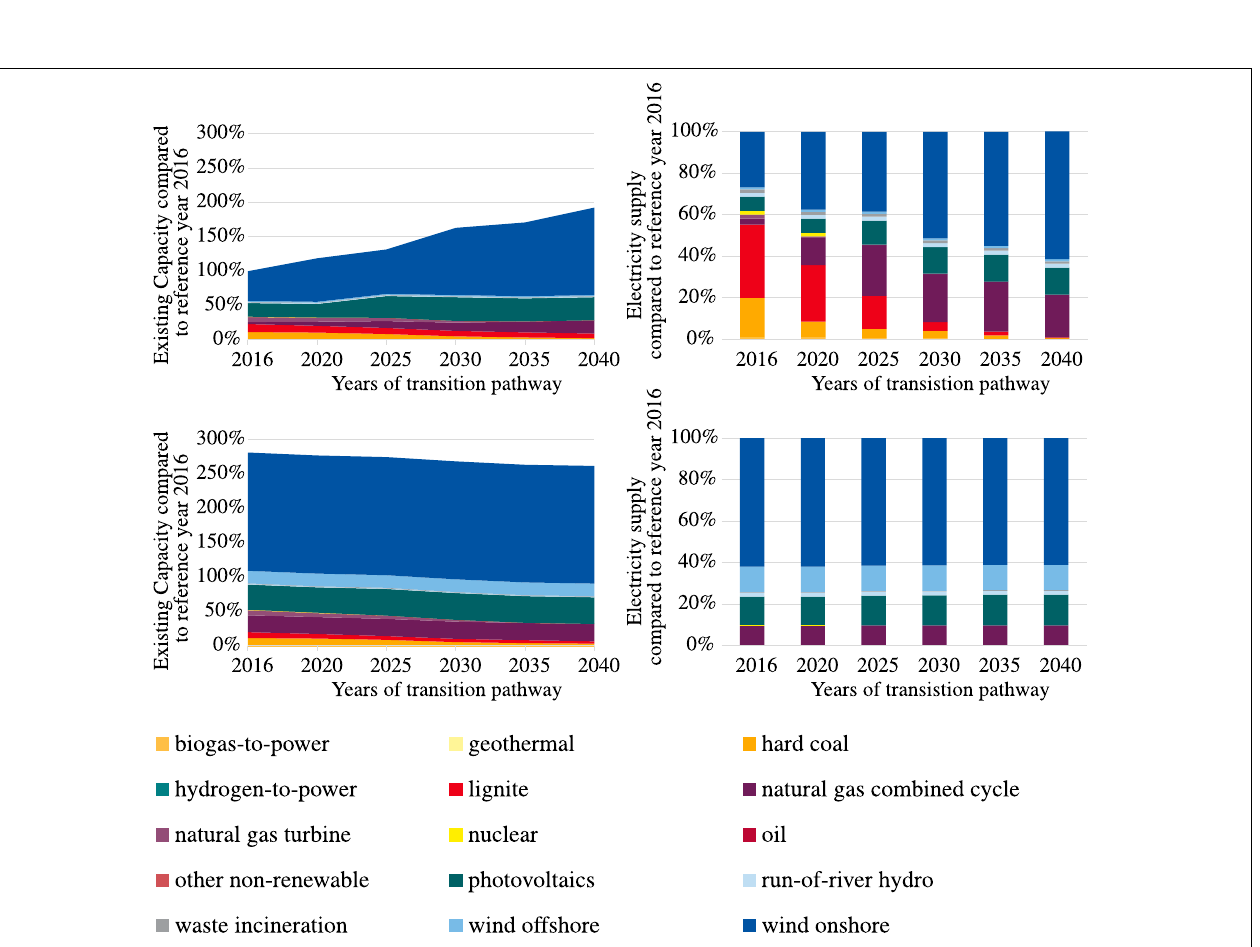
Frontiers in Energy Research |